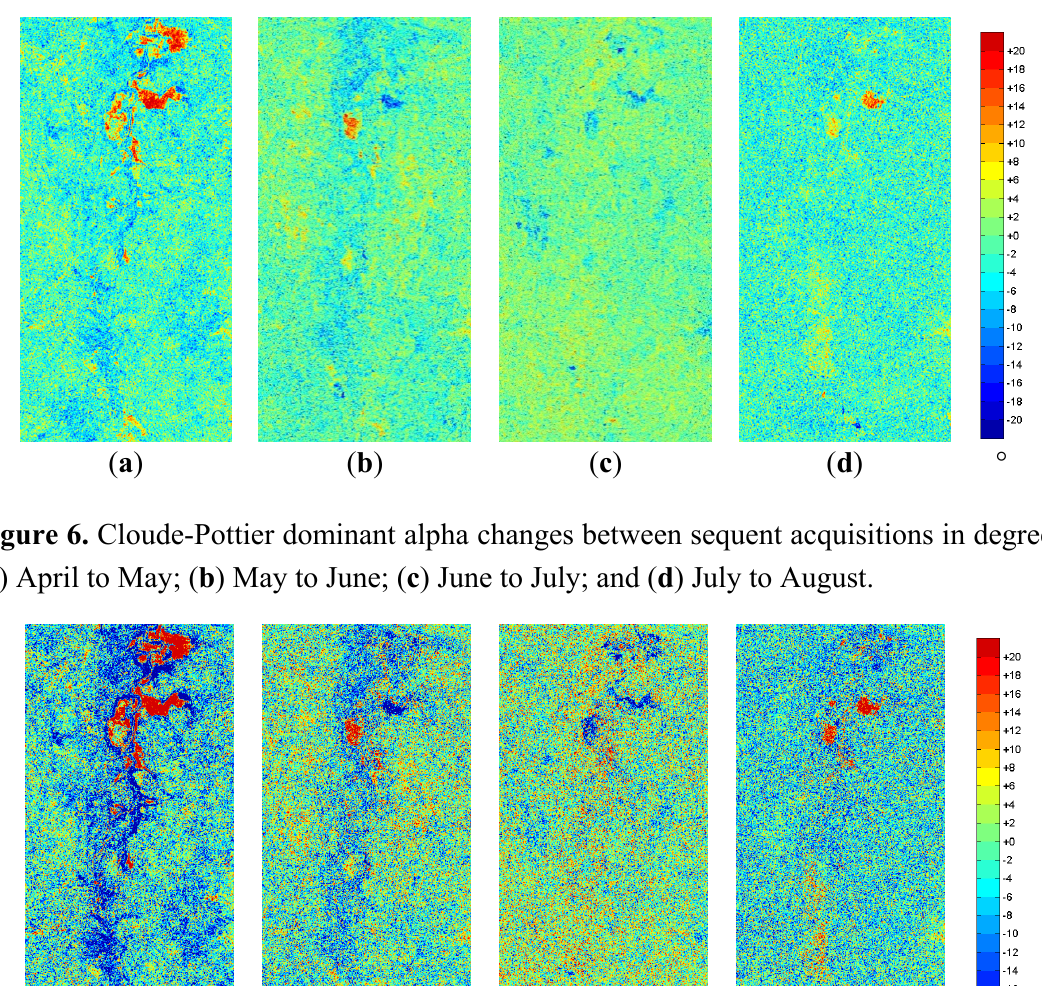
Figure 5. Cloude-Pottier mean alpha changes between sequent acquisitions in degrees: